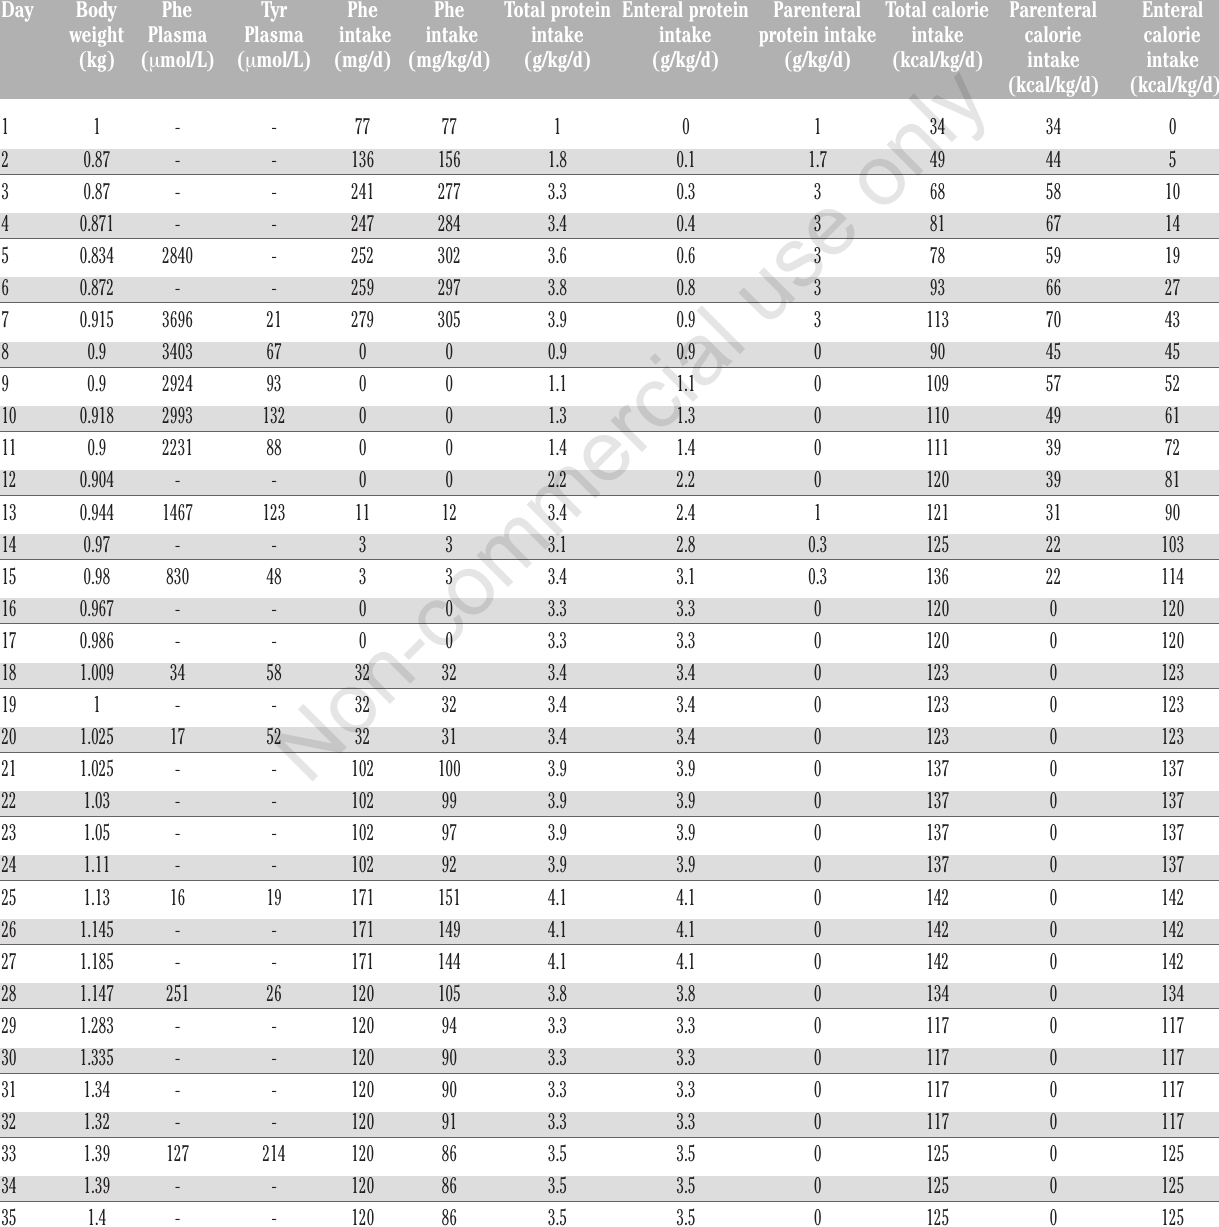
Table 1. Nutritional intake during the first 35 days of life: Detailed information about total calorie intake (kcal/kg/d), parenteral calorie intake (kcal/kg/d), enteral calorie intake (kcal/kg/d), total protein intake (g/kg/d), parenteral protein intake (g/kg/d), enteral protein intake, body